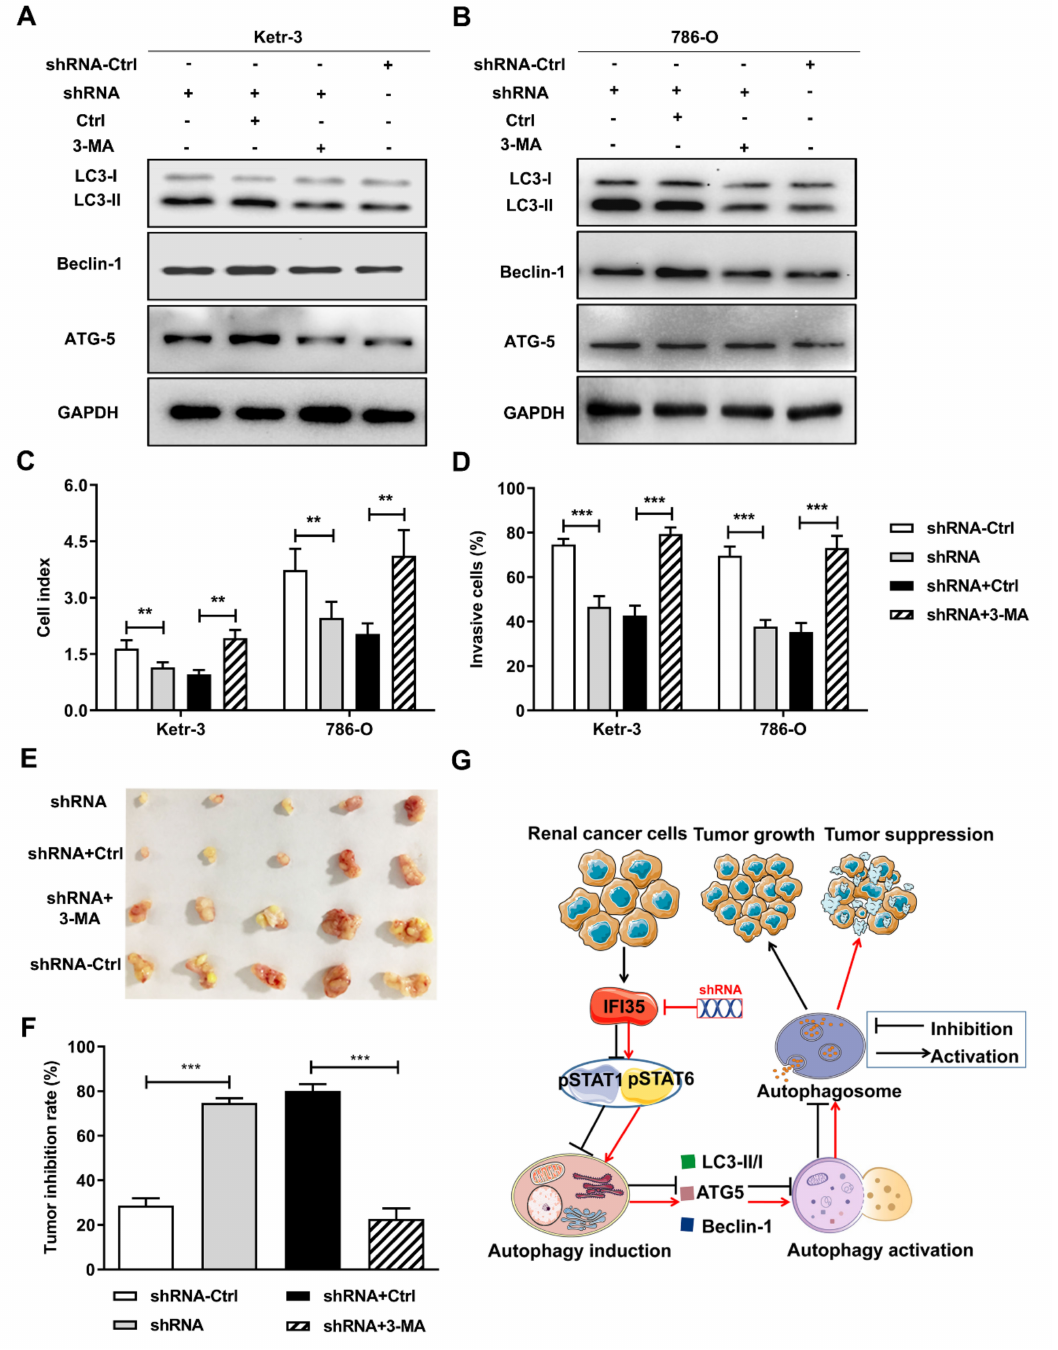
Figure 6. IFI35 knockdown therapeutic efficacy depended on autophagy induction. IFI35 knockdown Ketr-3 or 786-O cells were treated with or without inhibitor 3-MA. ( A , B ) Forty-eight hours after